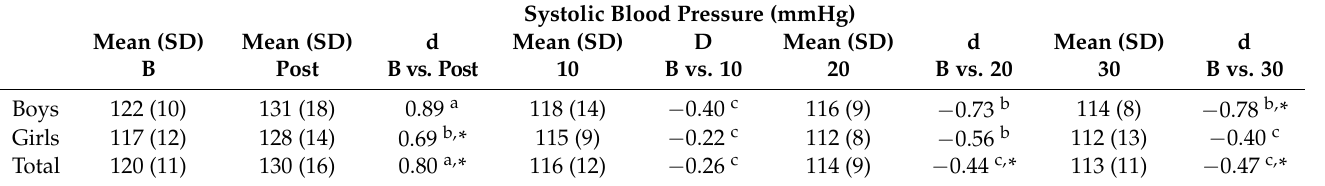
Table 2. Effect of a Muay Thai session on systolic blood pressure recovery in adolescents with